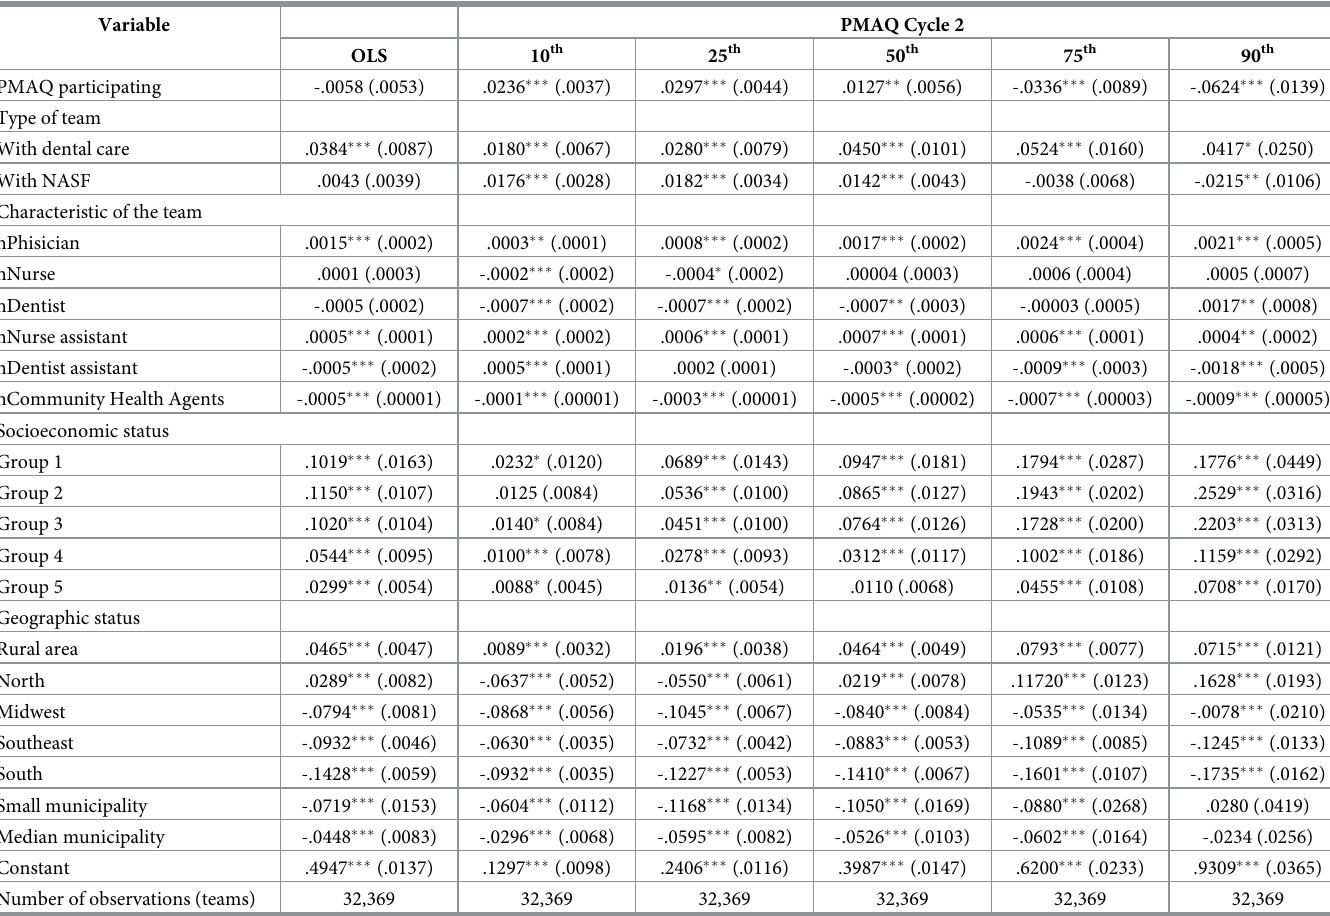
Table 3. Results from OLS and QR models for average number of consultations for childcare under 2 years old in the 2 nd cycle of PMAQ, Brazil.